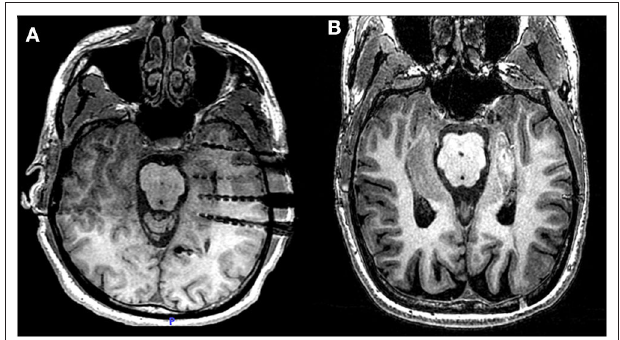
FIGURE 1 | Laser ablation after sEEG investigation. (A) Post-operative MRI of patient 2 showing three electrodes covering the head, the body and the tail of the hippocampus. From each electrode lead, two contacts are recording from hippocampal parenchyma. (B) Post-ablation MRI of the same patient, showing the extent of the lesion across the MT longitudinal